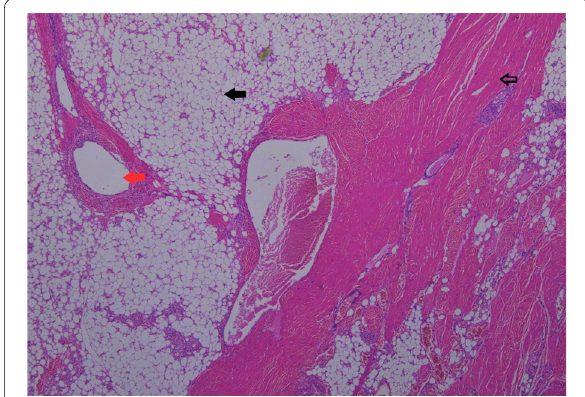
Fig. 9 Thick-walled blood vessels (solid red arrow) surrounding smooth muscle fibers (empty black arrow) and interposed adipocytes (solid black arrow)